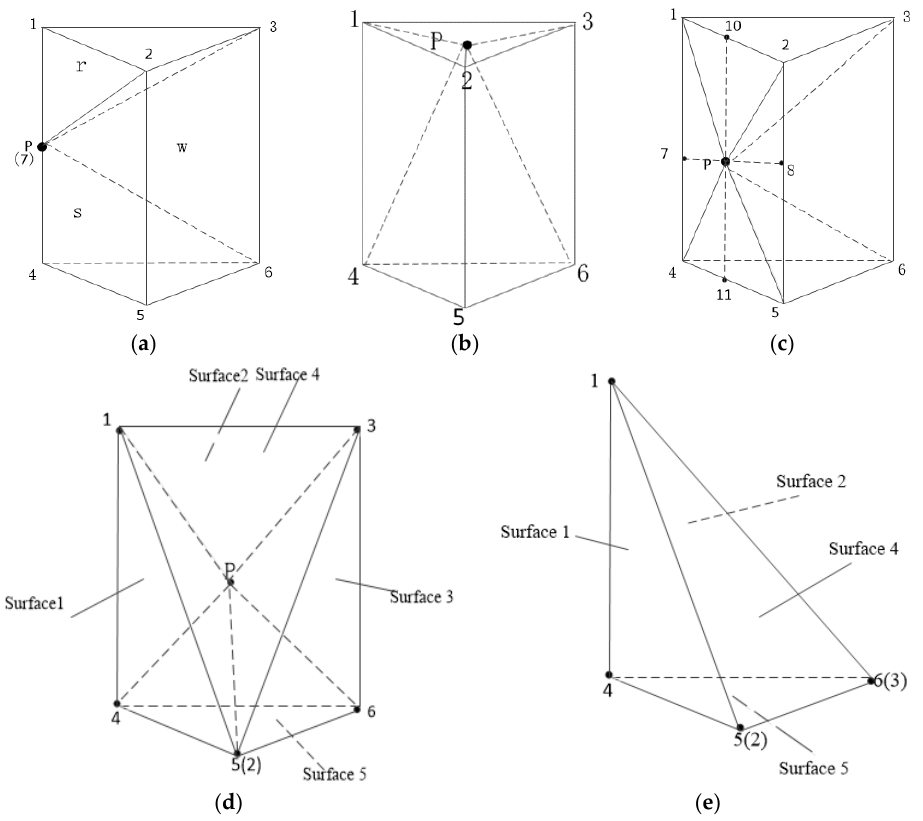
Figure 5. Different interpolation point situations in a triangular prism. ( a ) P on the edge of the triangular prism; ( b ) P at the bottom of the triangular prism; ( c ) P at the side of the triangular prism; ( d ) P in pyramid; ( e ) P in tetrahedron.